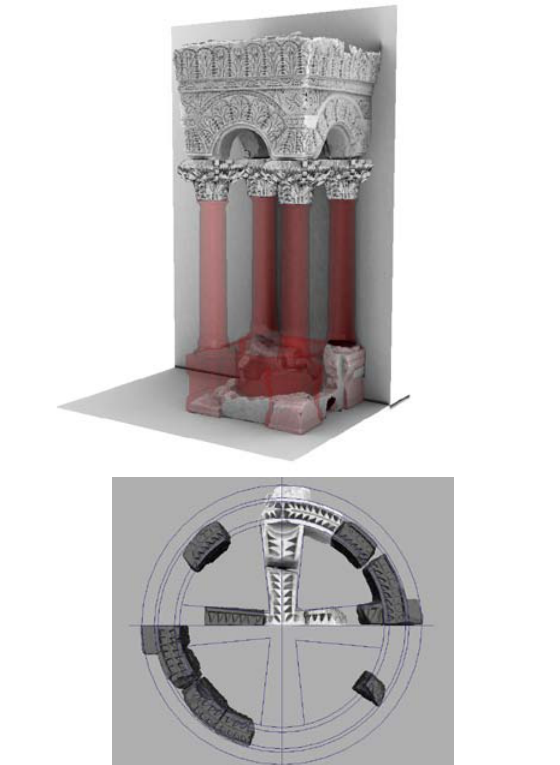
Figure 10. Cross-sections of the different cisterns surveyed